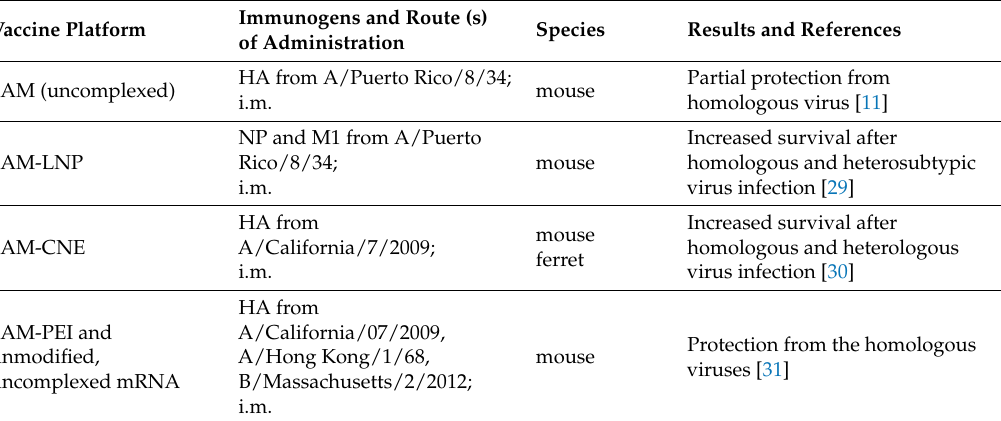
Table 1. RNA vaccines against influenza